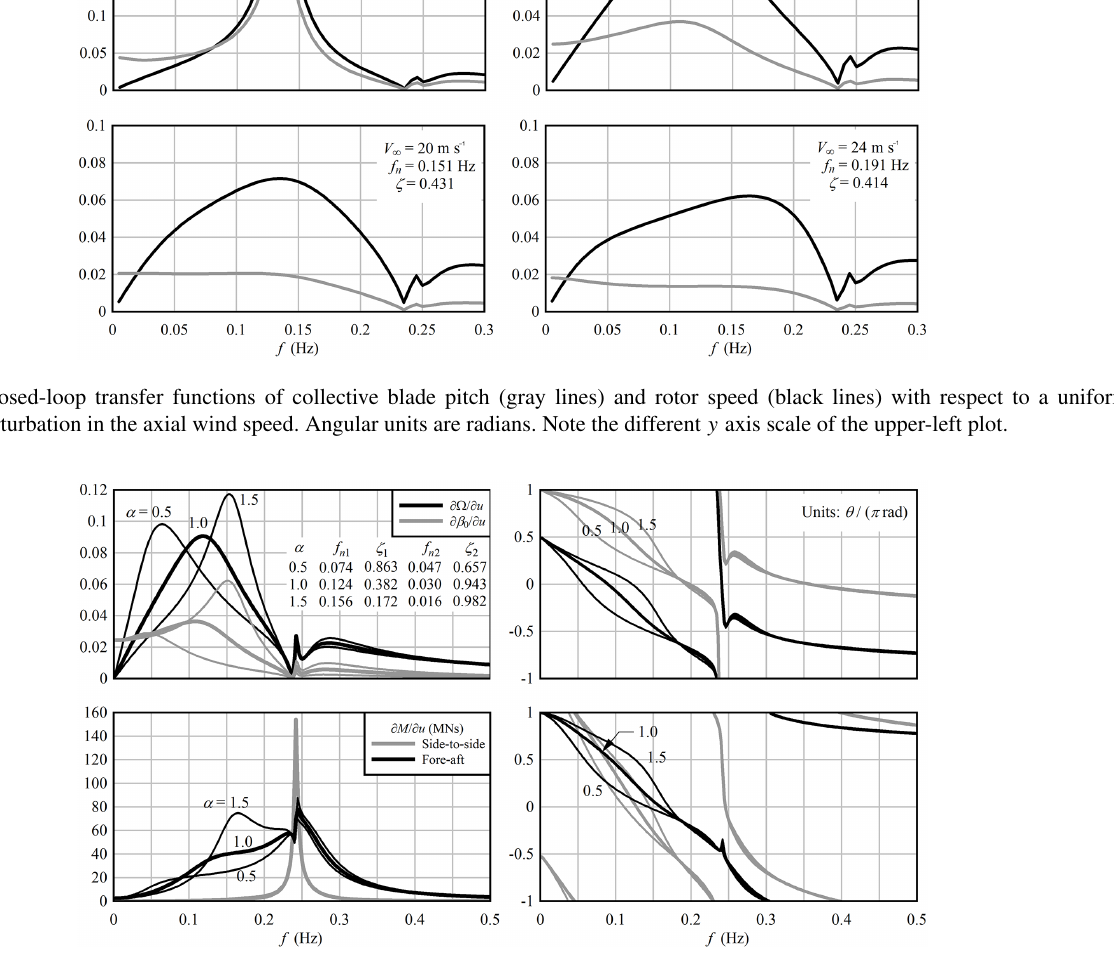
Figure 3 plots the transfer functions of blade pitch, rotor speed, and tower mud line bending moments, with respect to a uniform fluctuation in the axial wind speed. The frequency and damping properties of the rotor speed control and dy- namic wake modes are tabulated as a function of the gain function is dominated by the rotor speed control mode,